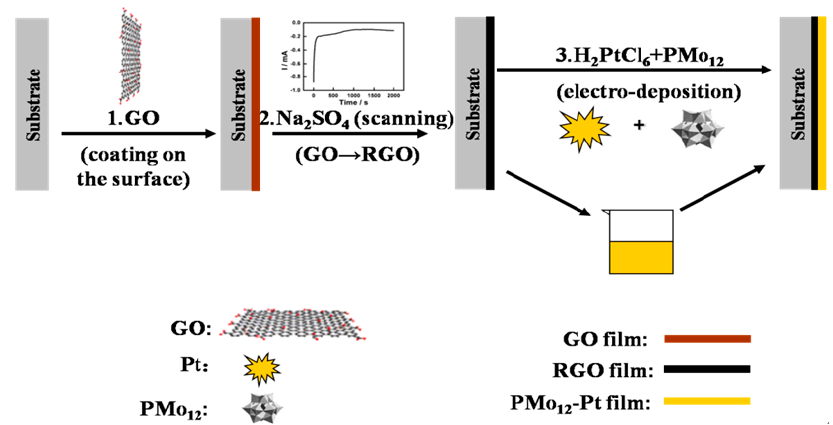
Figure 1. Schematic preparation of PMo 12 -Pt/rGO composites.